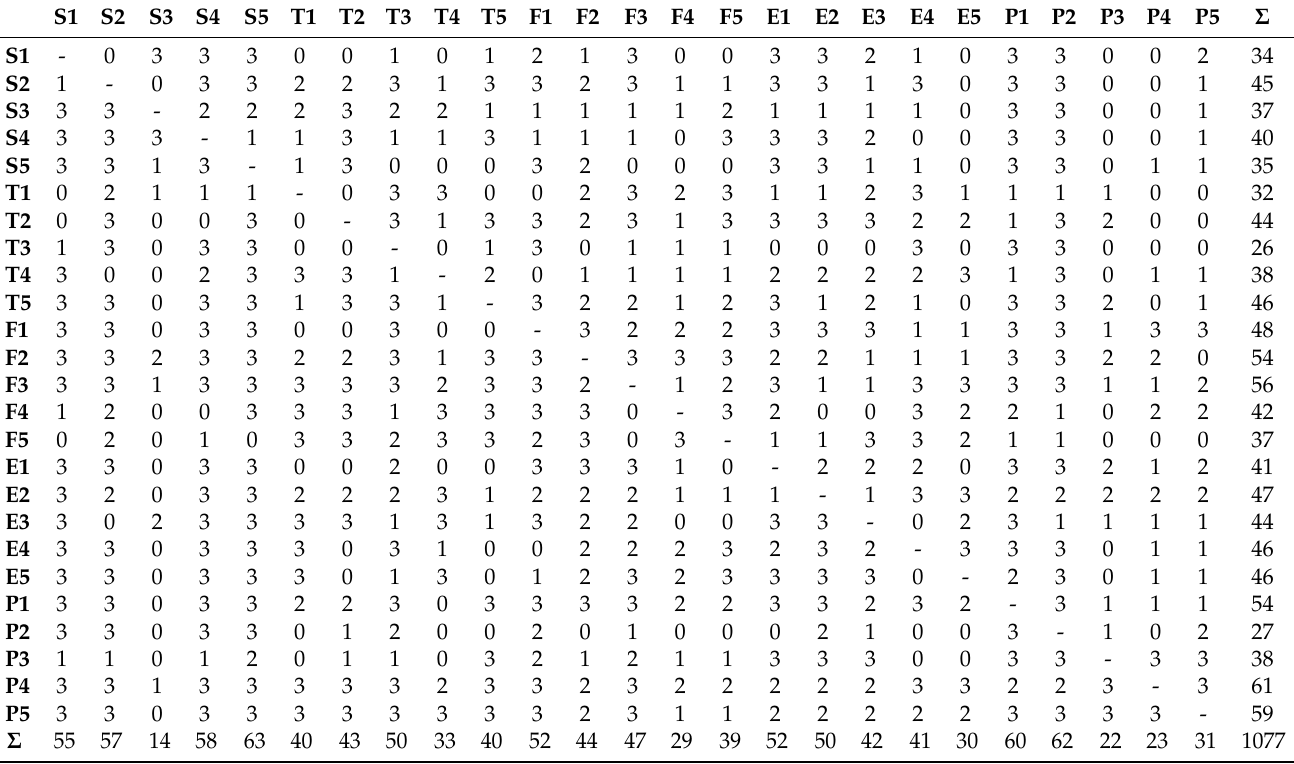
Table 3. Matrix of direct influence of BSSs’